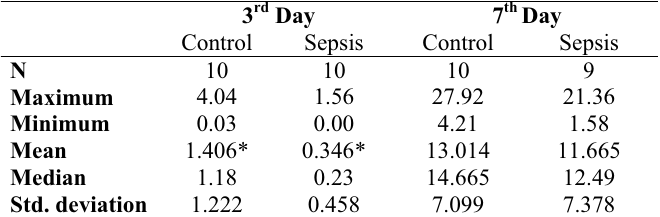
TABLE 2 - Breaking tensile strength of animals sacrificed on the third and seventh days expressed in Newtons (N)